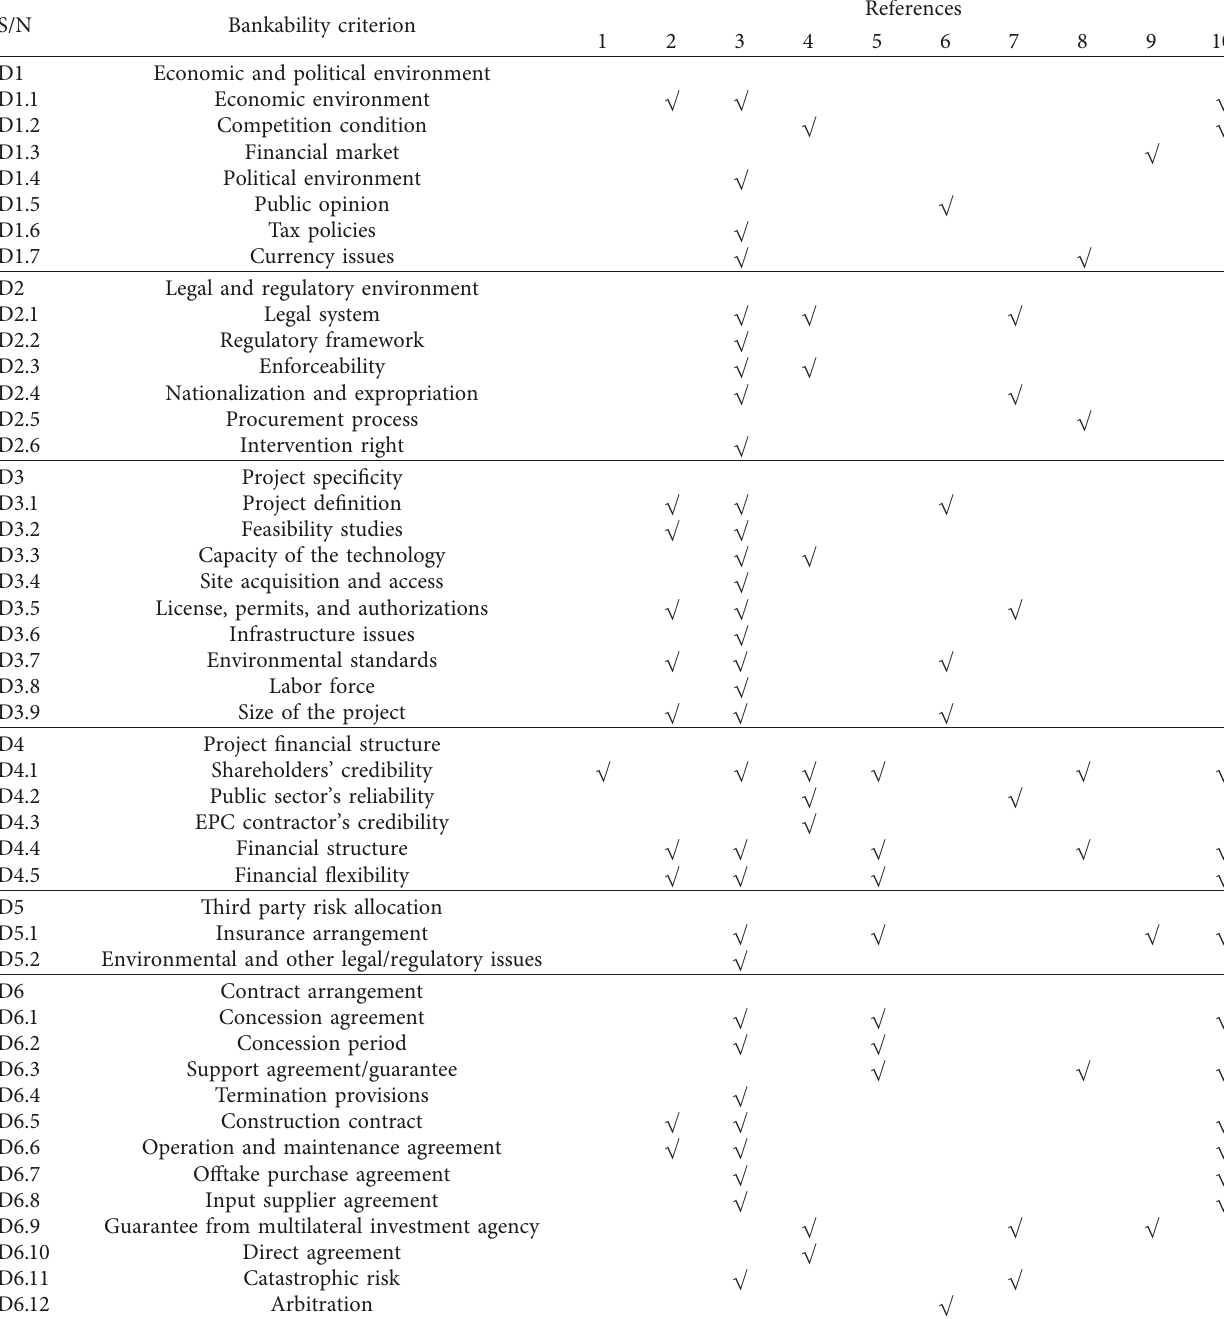
Table 1: Identified bankability criteria for PPP